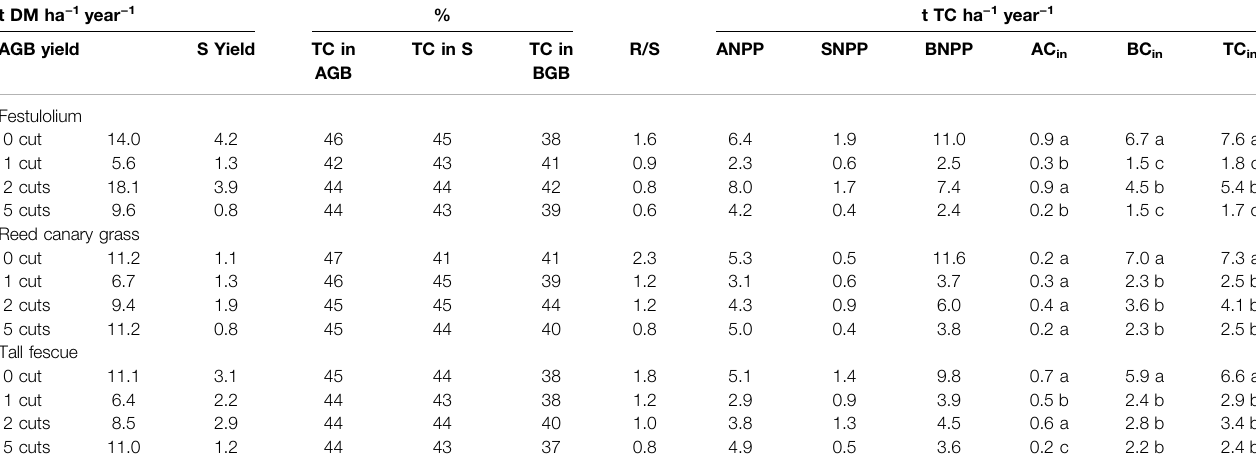
TABLE5| Totalannualharvestedbiomassyieldsintdrymatter(DM)ha − 1 year − 1 ofthethreeperennialgrassesunderthevarioustreatments,thecontentoftotalcarbon(TC) in aboveground (AGB), stubble (S), and belowground (BGB) biomass and the determined root:shoot ratio (R/S), used for the calculation of aboveground net primary productivity (ANPP), stubble net primary productivity (SNPP), and belowground net primary productivity (BNPP), the input of carbon into soil from aboveground biomass residues (AC in ) and belowground biomass (BC in ), resulting in the total carbon input (TC in ) over a rooting depth of 50 cm. Letters indicate differences between treatments, where treatments with the same letters are not signi fi cantly